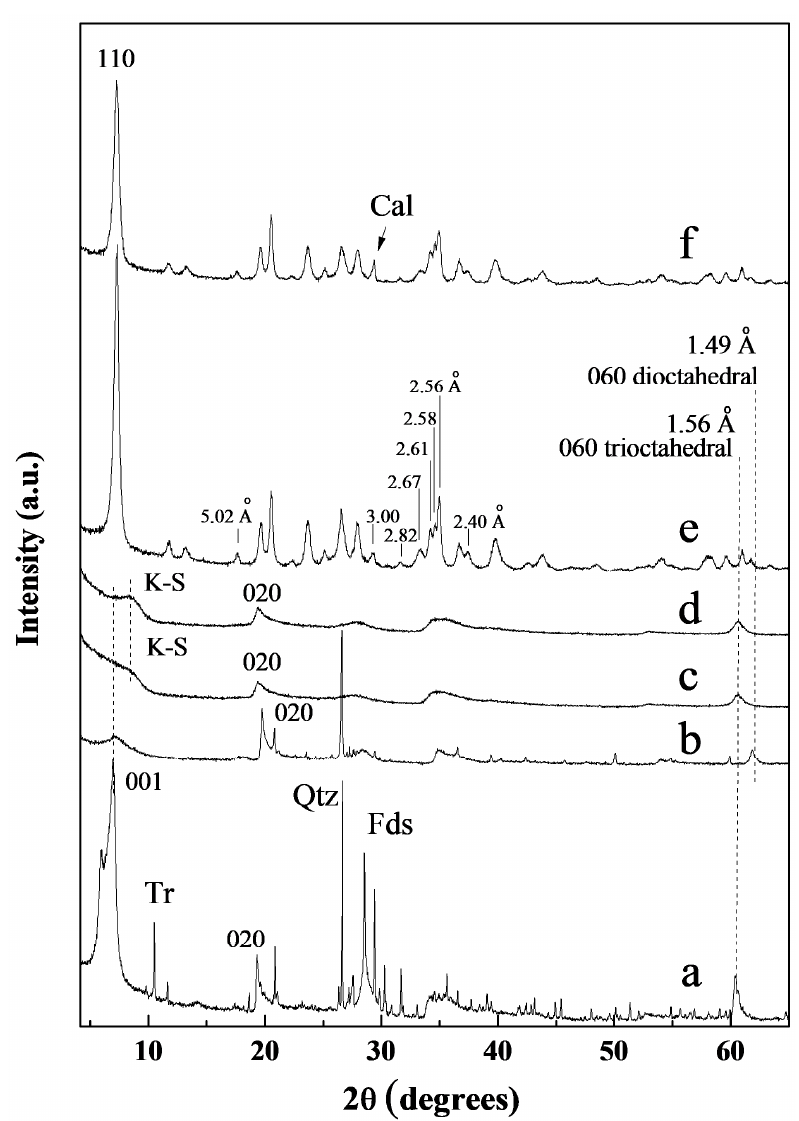
Figure 1. X-ray diffractograms of Bs ( a ), Bm ( b ), K1 ( c ), K2 ( d ), Sp1 ( e ) and Sp2 ( f ). Qtz: Quartz; Fds: Feldspars; Tr: Tremolite; Cal: Calcite.